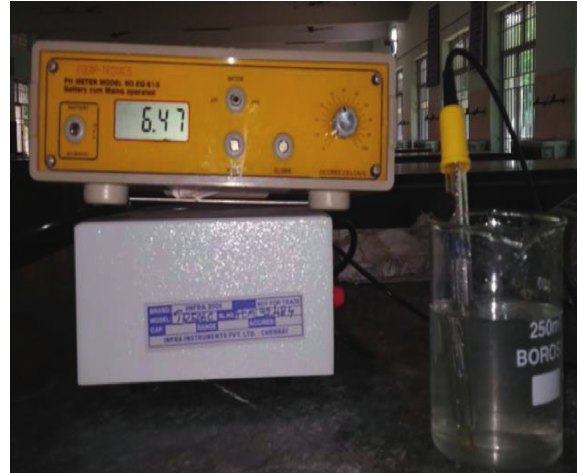
Figure 10: Sample solution pH value.